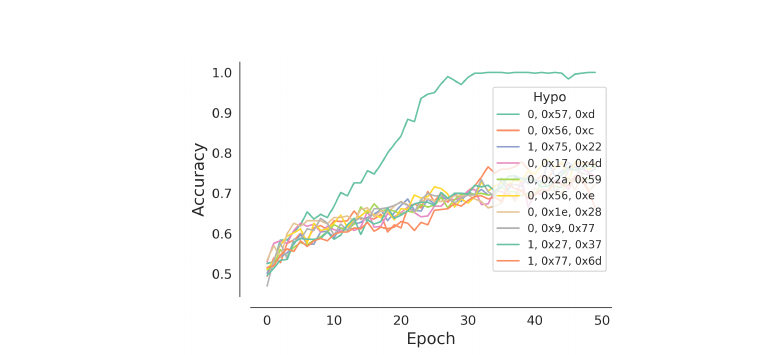
Figure 25: Performing the first step of the attack with DDLA, using 256 traces.